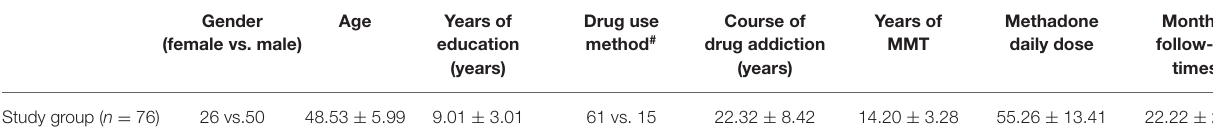
TABLE 1 | The general clinical characteristics of the MMT-receiving subjects included. Gender (female vs. male)